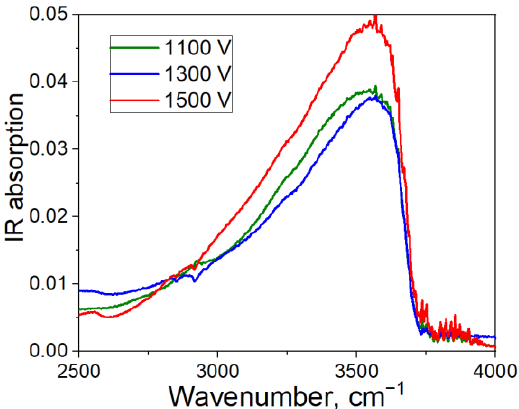
Figure 4. Differential (minus the spectrum of the initial glass) IR spectra of the specimens poled under 1100, 1300 and 1500 V.